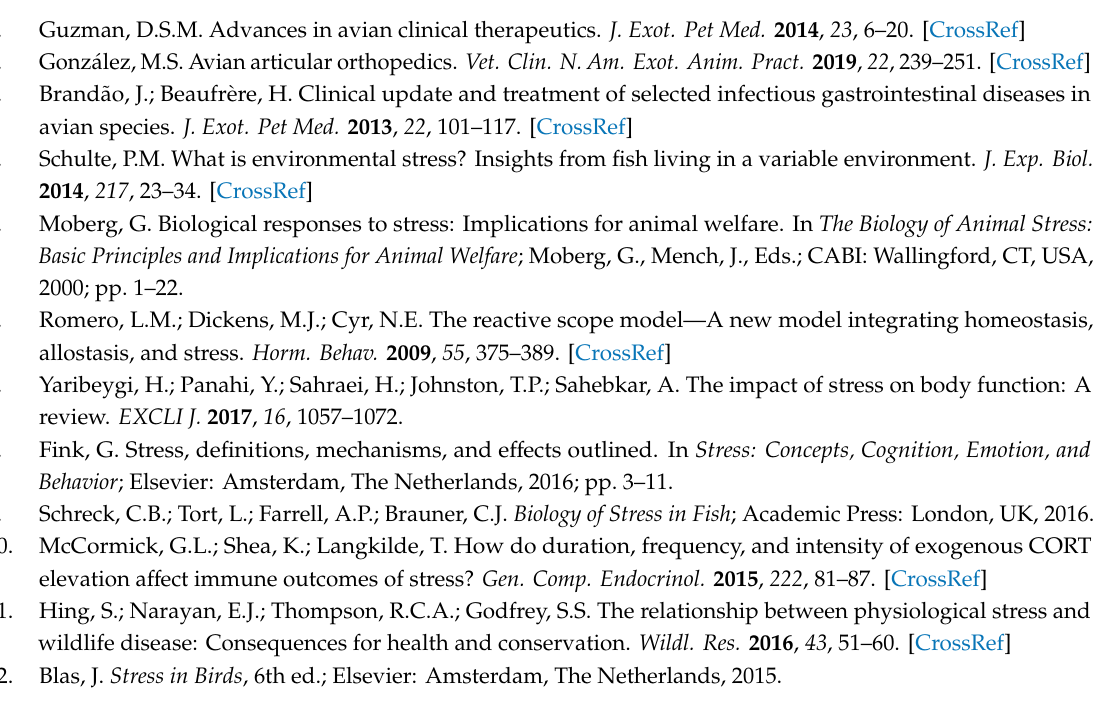
Table S1: Raw Data Related to Bird